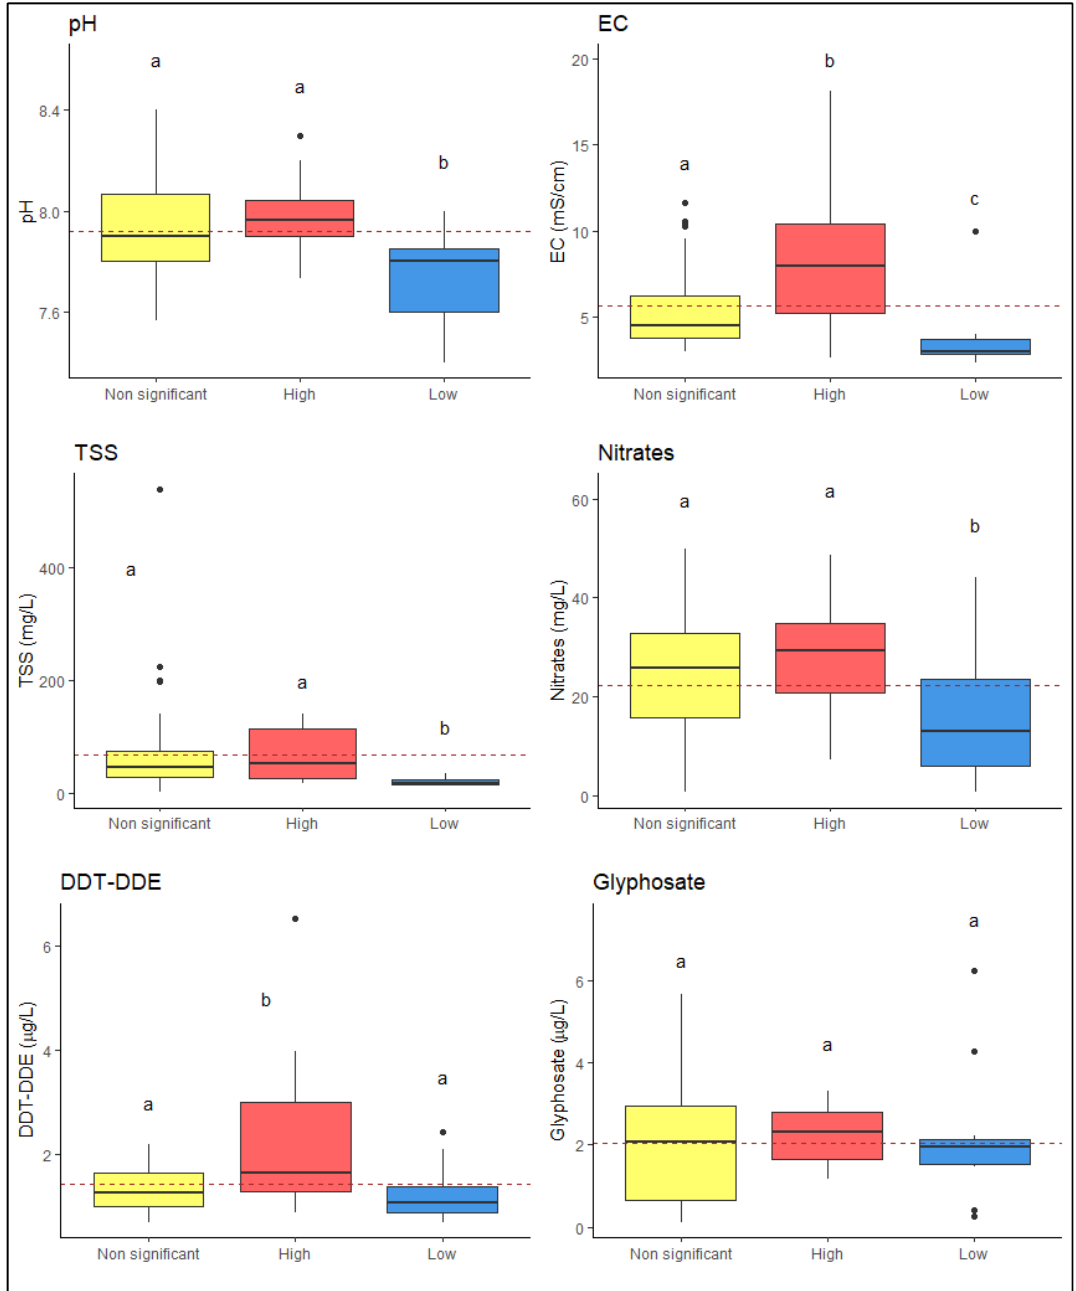
Figure 3. Box plots of the water quality parameters. The x -axis categories were obtained from the Getis–Ord (𝐺 (cid:3036)∗ ) statistic results. Dashed brown lines represent the mean values of each water quality parameter. The color code of the boxplots is the same of the Getis–Ord maps. Different letters above the boxplots denote subgroups, according to Dunn’s test post hoc analysis.